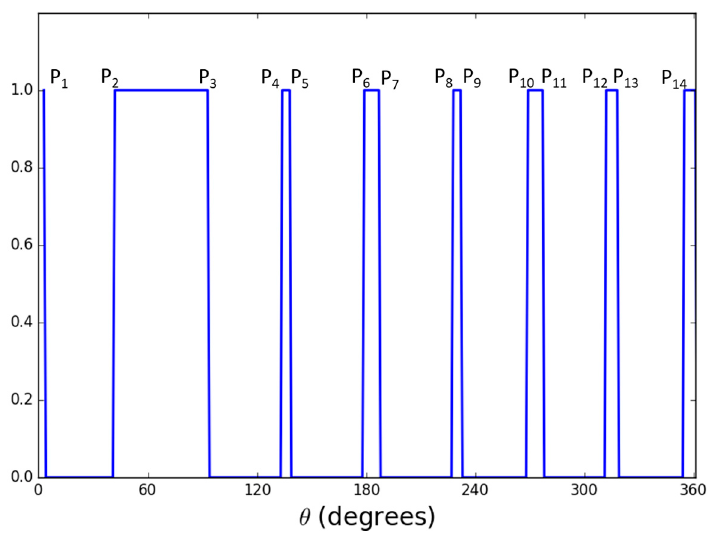
Figure 5. Binarized profile extracted from the measured circle of Figure 4.